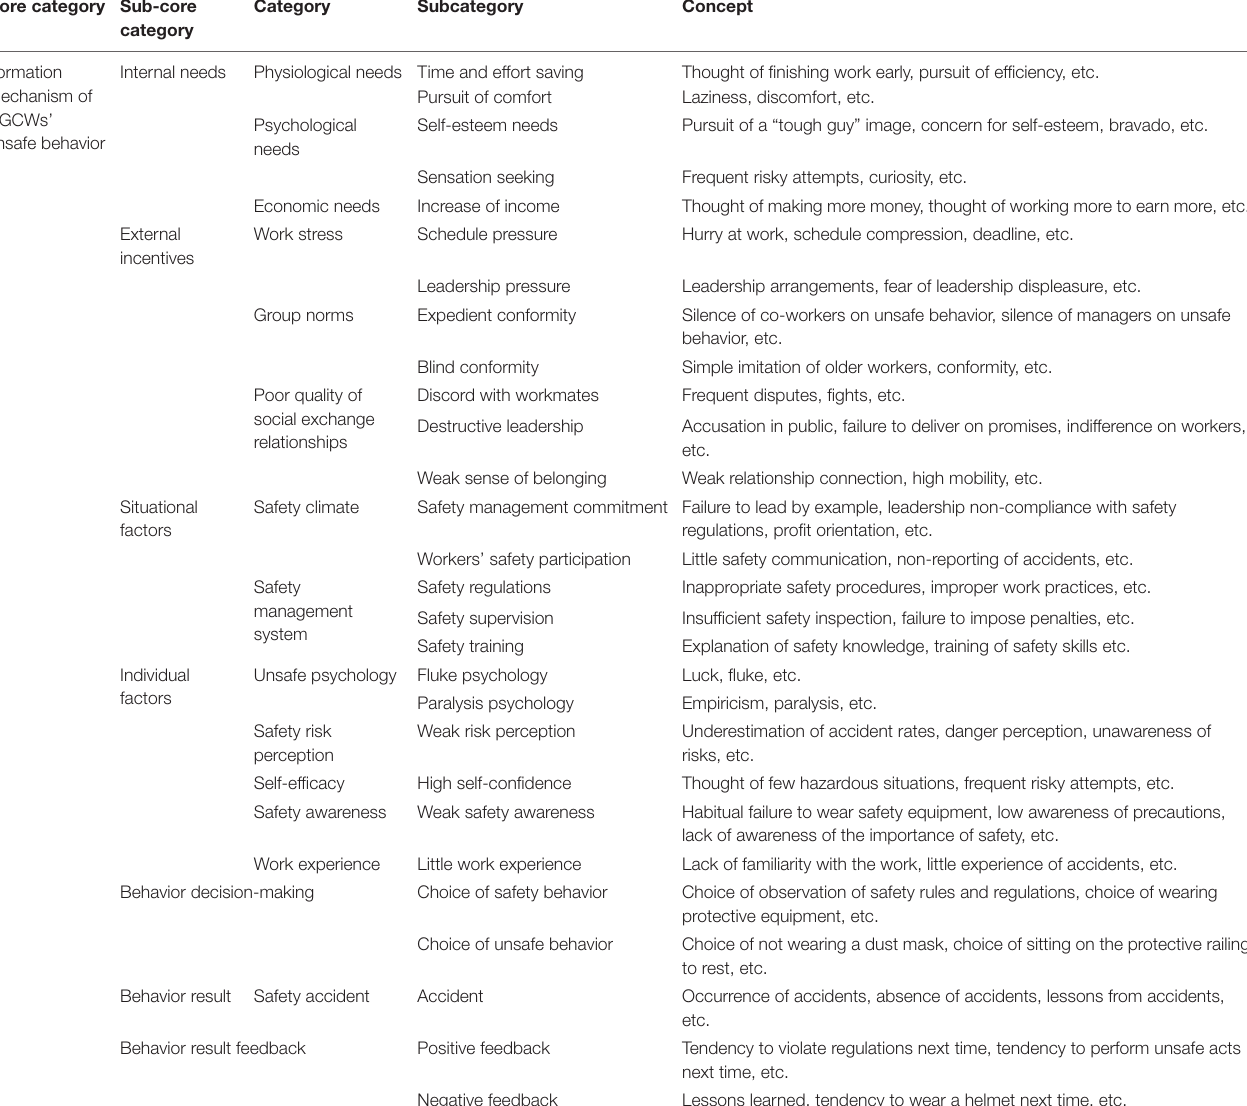
TABLE 4 | Coding results. Core category Sub-core